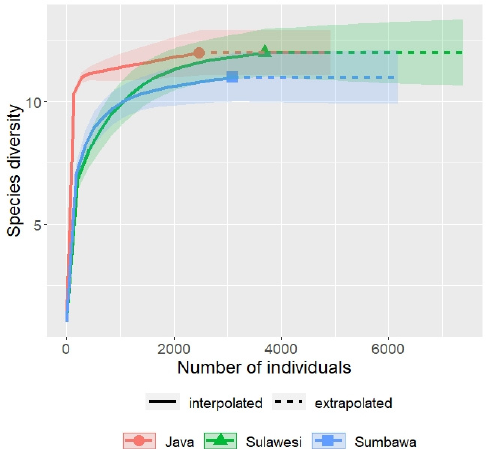
Figure 2. Comparison of the ambrosia beetle species richness on three observed Islands. Rarefaction (solid line segment) and extrapolation (dotted line segments) sampling curves at 95% confidence intervals (shaded areas). The solid dots/triangles represent the reference samples.